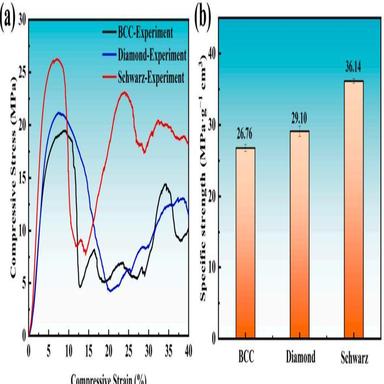
Compression testing results of the as-built 2024-5 vol% TiCN lattice structures, (a) compressive stress-strain curves, and (b) specific strength.